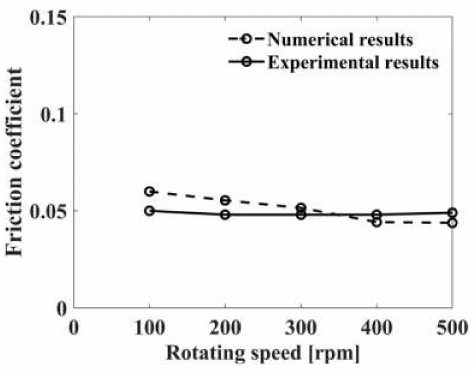
Figure 5. Comparison of simulated friction coefficients with measured ones.